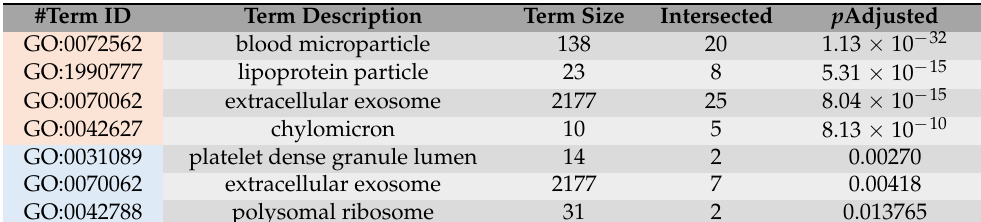
Table 3. GO Cell Component analysis of the proteins enriched or underrepresented in SEC3 vs. INV. Red color denotes enrichment in SEC3 preparations, and blue color that the group is underrepresented in SEC3 vs. INV. #Term ID Term Description Term Size Intersected p Adjusted GO:0072562 blood microparticle